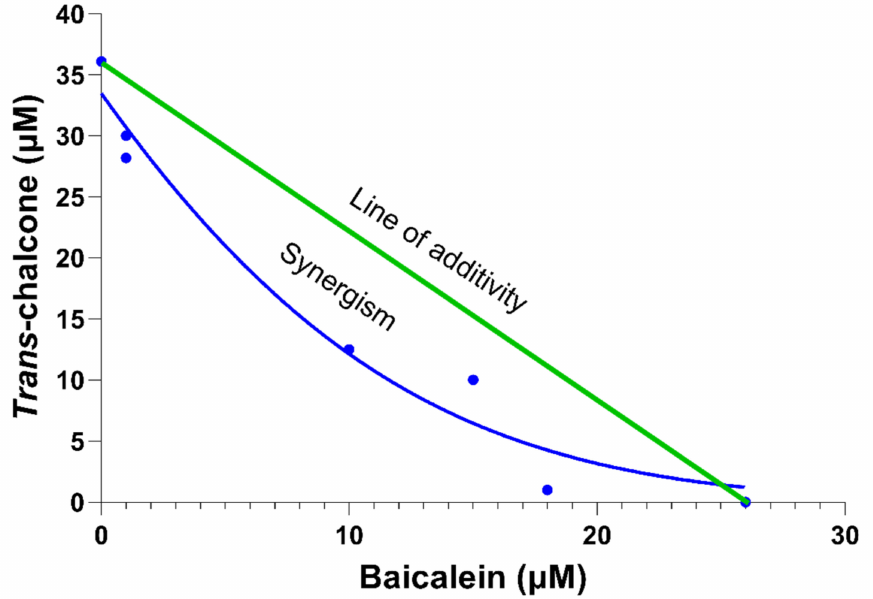
Figure 4. An isobologram created using the 50% inhibitory concentration (IC50) that reduced 50% of the GFP-A β 42 positive cells after treating BY4743 ∆ ahp1 [p416.GPD.GFPA β 42 ] cells with baicalein, trans -chalcone and their combinations. The X -axis represents concentration of baicalein; Y -axis represents the concentration of trans -chalcone; green line is the theoretical line of additivity; blue dots are the observed IC50 values obtained after treating the cells with the combinations; and the blue curved line is a Gaussian curve showing the combination of baicalein and trans -chalcone was synergistic in reducing GFP-A β 42